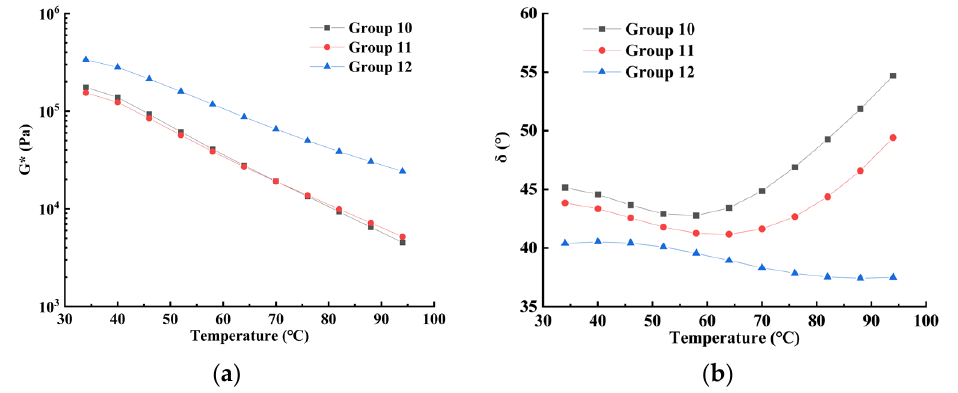
Figure 3. The temperature scanning test results. ( a ) The complex shear modulus; ( b ) the phase angle.